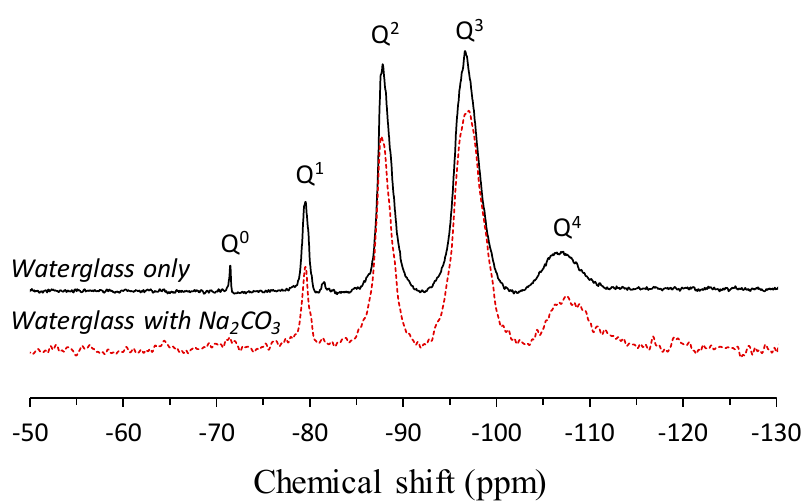
Figure 5. Liquid-state 29 Si NMR spectrum of waterglass and solid-state 29 Si MAS NMR spectrum of waterglass mixed with Na 2 CO 3 .